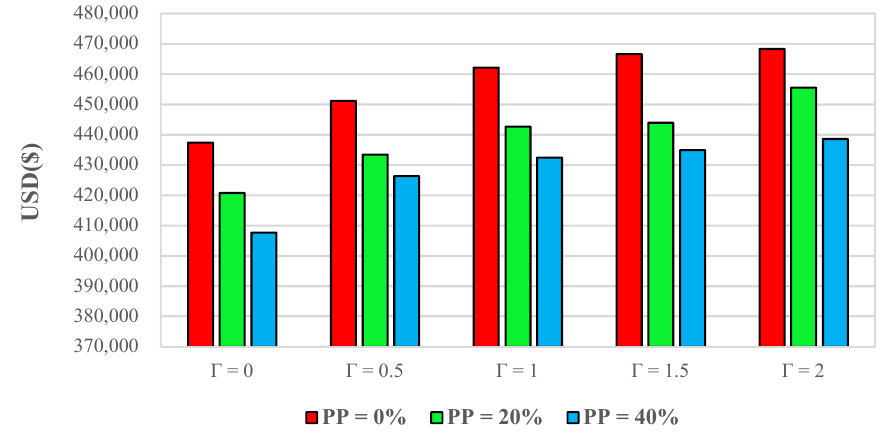
Figure 6. NPC for simulation with a 10% uncertainty set.